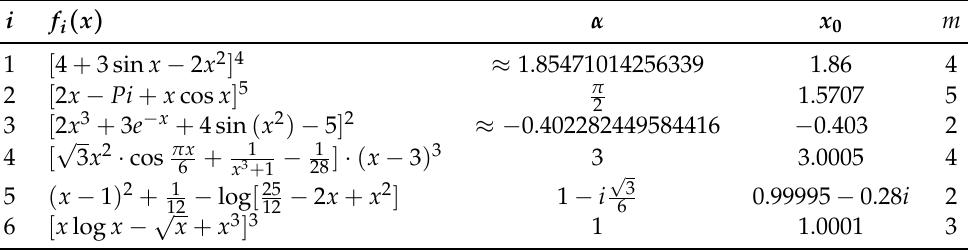
Table 3. Additional test functions f i ( x ) with zeros α and initial values x 0 and